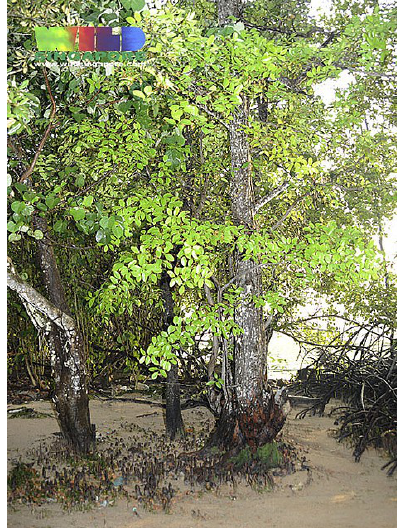
Figure 13. Xylocarpus moluccensis . Note: this picture is reproduced with permission of Ron Yeo. Copyright © 2013 Ron Yeo (Ron